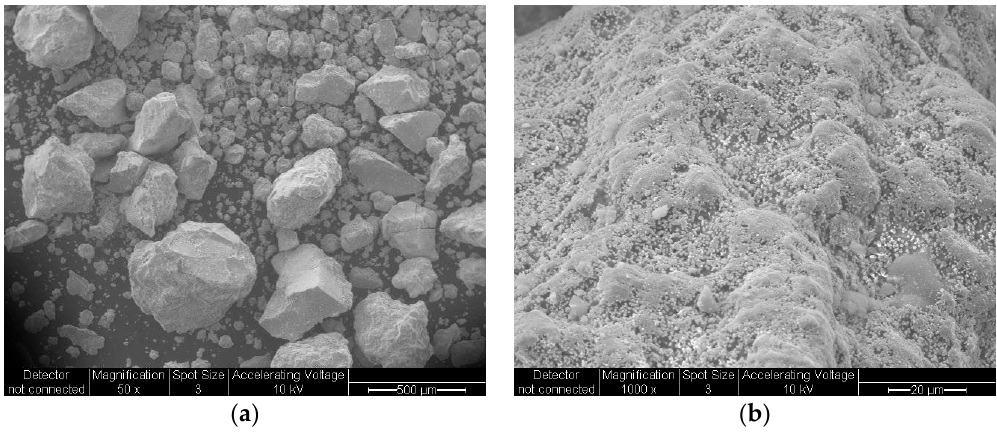
Figure 16. Scanning electron microscopy of sample Co/Si = 1/5 using uncoated silica and processed using the Haake Mixer (Section 3.4.1) followed by heat treatment at 600 °C using Method ‐ C; (Section 3.8) at two magnifications. ( a ) Scale bar = 500 μ m; ( b ) Scale bar = 20 μ m.